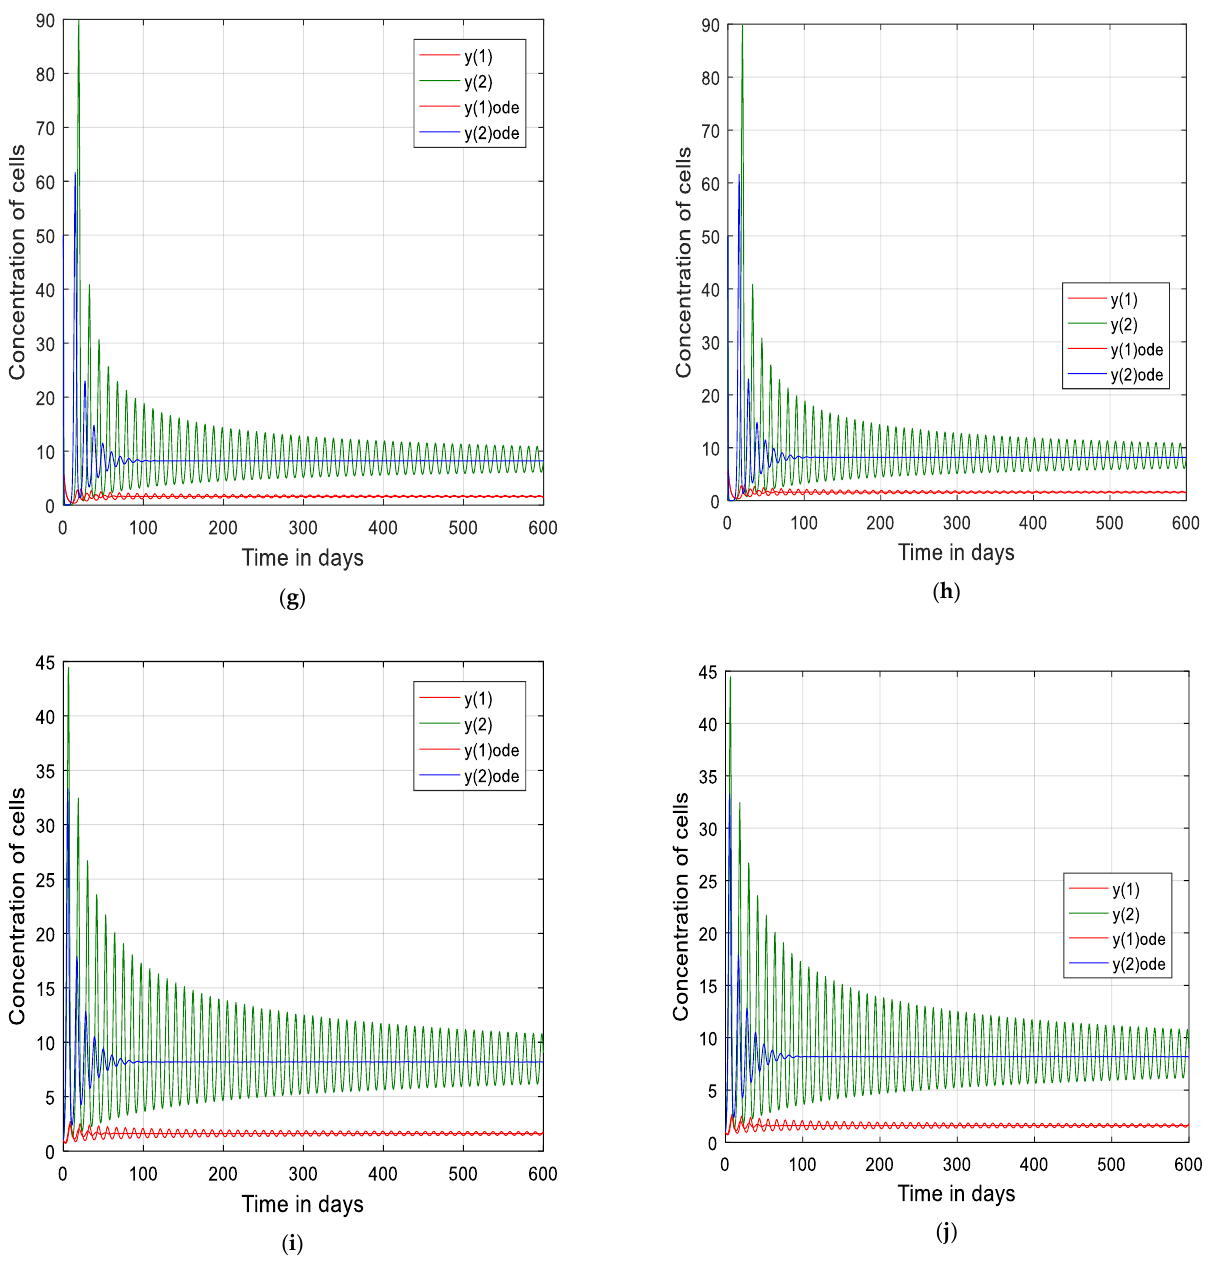
Figure 3. Illustration of decay oscillation to the dormant tumor state of the rate of concentration of the effector cells and IL-2 along the time t in days, y 1 ( t )[ · − ·− ] effector cells, and y 2 ( t )[ · · · · · ] tumor cells.